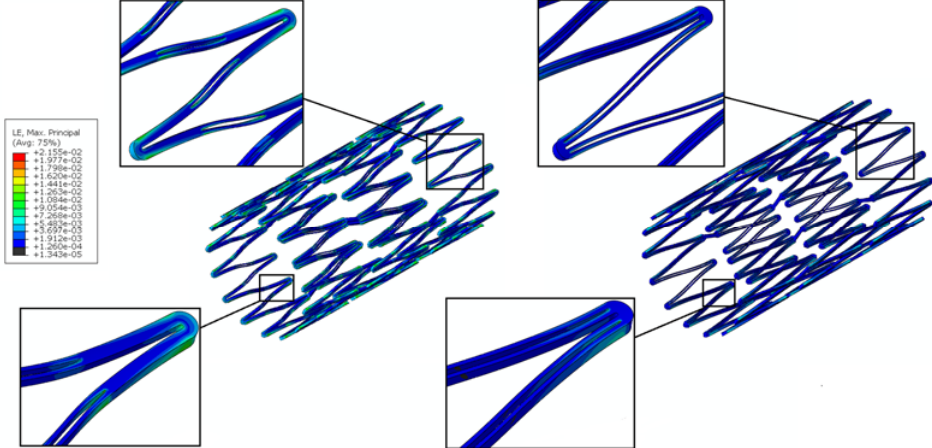
Figure 13. FEA contour plot comparison of strain distribution at 7.0 mm after release into a blood vessel between rhombic-shaped channel stents with reservoir lengths of 40% ( left ) and 100% ( right ) of the strut length.